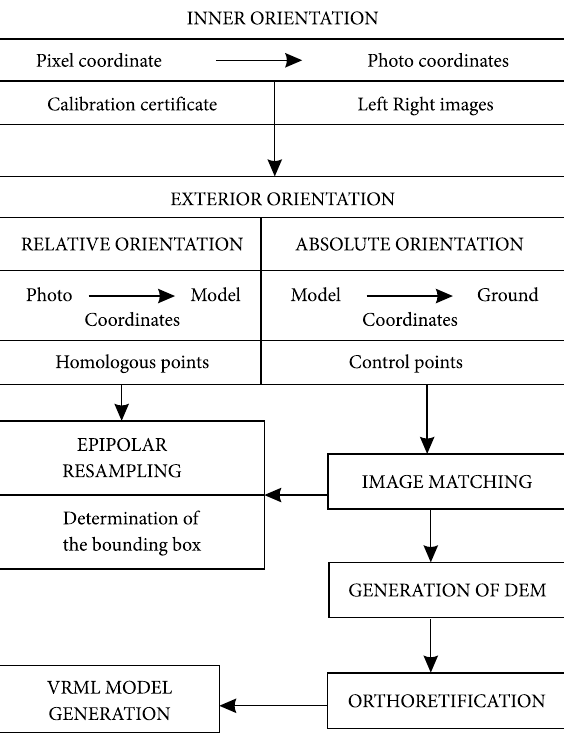
Fig. 1. General workflows on DDPS